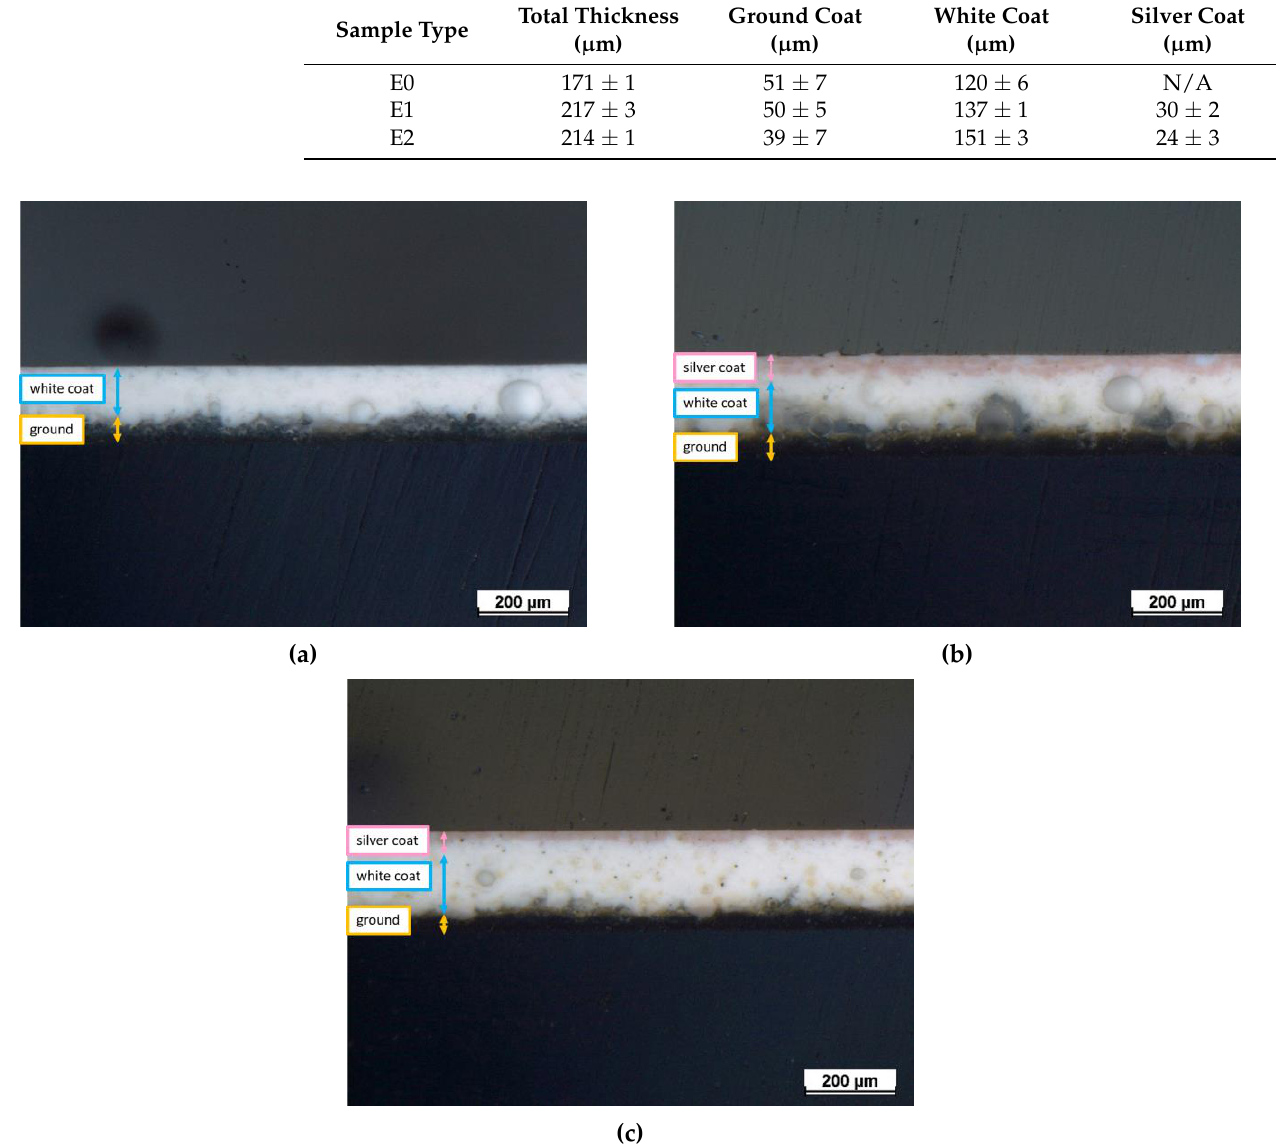
Figure 3. Optical cross-sectional micrographs of ( a ) reference sample E0, ( b ) sample E1, and ( c ) sample